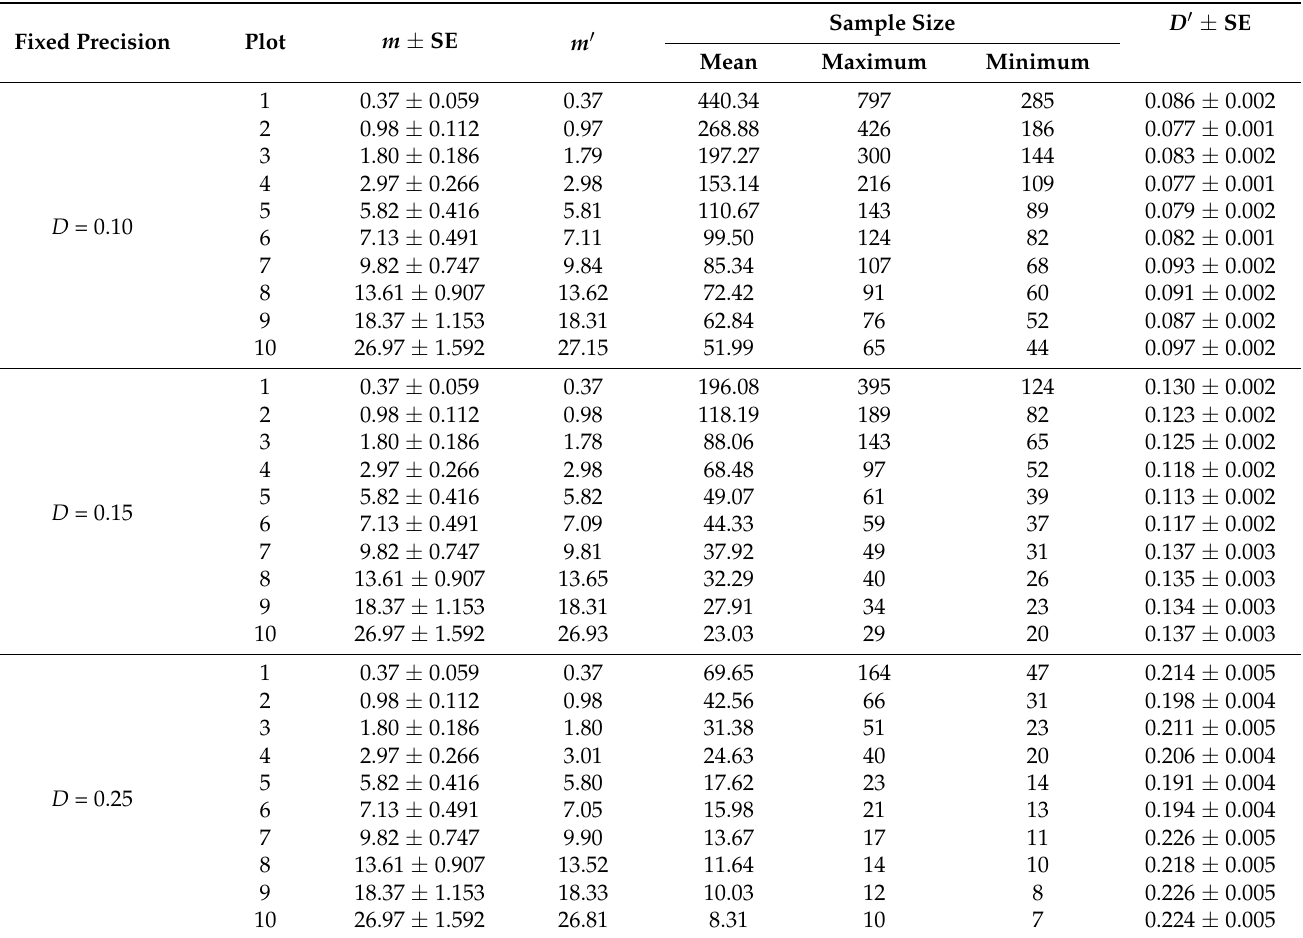
Table 1. Statistical results for 1000 repetitions of bootstrap resampling. Sequential enumerative sampling with fixed precision ( D = 0.10, 0.15 and